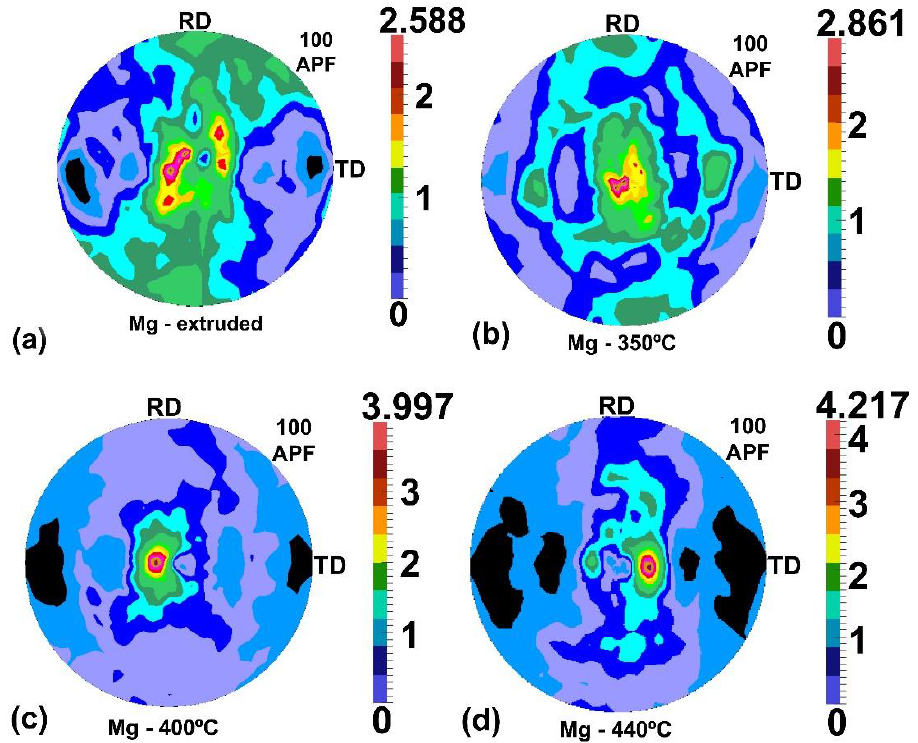
Figure 9. The complete pole figures (10.0) for the as-extruded material ( a ) and for the material ex- truded and drawn at t350 ( b ), t400 ( c ), and t440 ( d ). extruded and drawn at t350 ( b ), t400 ( c ), and t440 ( d